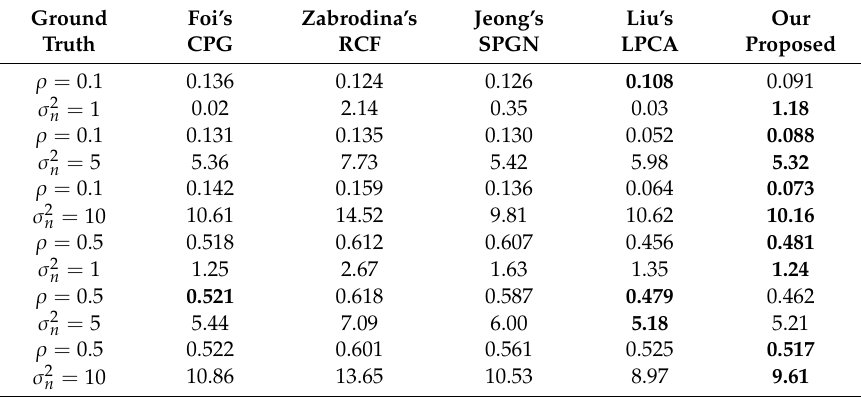
Table 5. The results of di ff erent PGN estimation algorithms on the Kodak PCD0992 images. Ground Truth